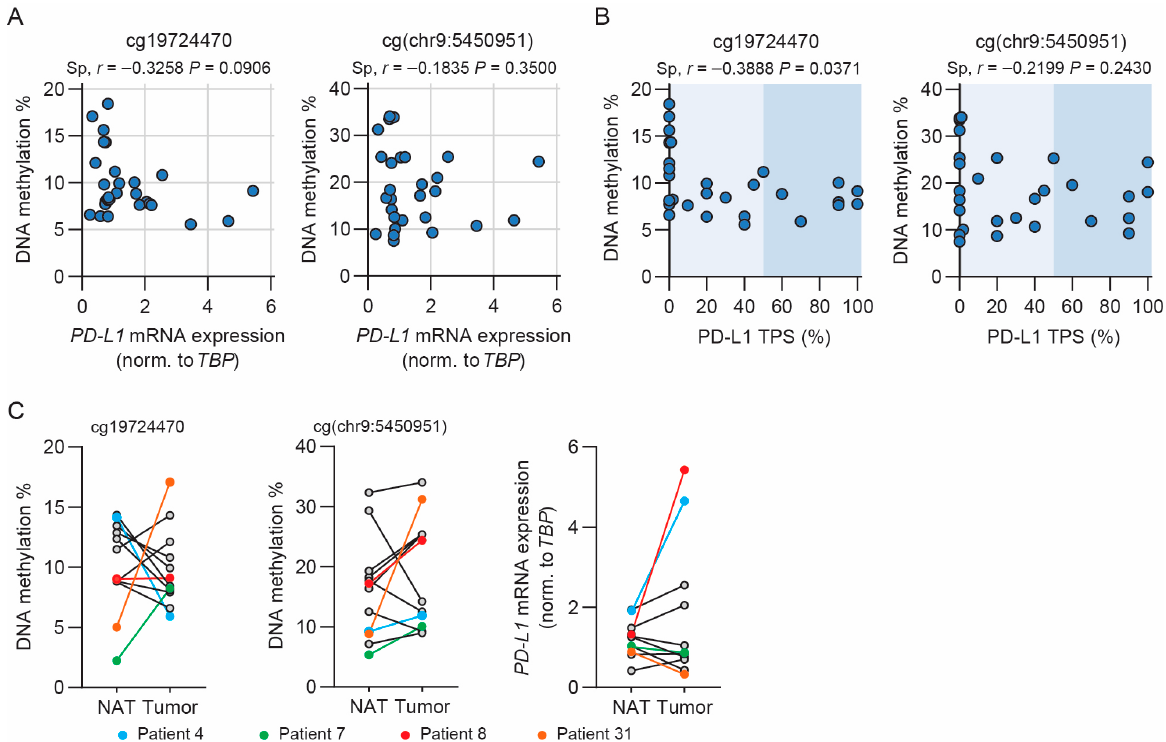
Figure 5. PD-L1 methylation and mRNA expression in NSCLC tumor biopsies. ( A ) Spearman’s correlation analysis of PD-L1 mRNA expression and DNA methylation of cg19724470 and cg(chr9:5450951), respectively, in NSCLC tumor tissue ( n = 28). Spearman’s correlation coefficients ( r ) and the p -values are depicted above the graph. ( B ) Correlation analysis of PD-L1 TPS and DNA methylation of cg19724470 ( n = 29) and cg(chr9:5450951) ( n = 30), respectively, in NSCLC tumor tissue. Spearman’s correlation coefficients ( r ) and the p -values are depicted above the graph. Shading represents clinically used PD-L1 TPS subdivisions (<1%, 1–49%, and ≥ 50%). ( C ) DNA methylation of cg19724470 ( n = 12) and cg(chr9:5450951) ( n = 12) and PD-L1 mRNA expression normalized to TBP ( n = 11) in normal adjacent tissue (NAT) and tumor tissue, connected by a line for each patient. The selected patients are marked by color.